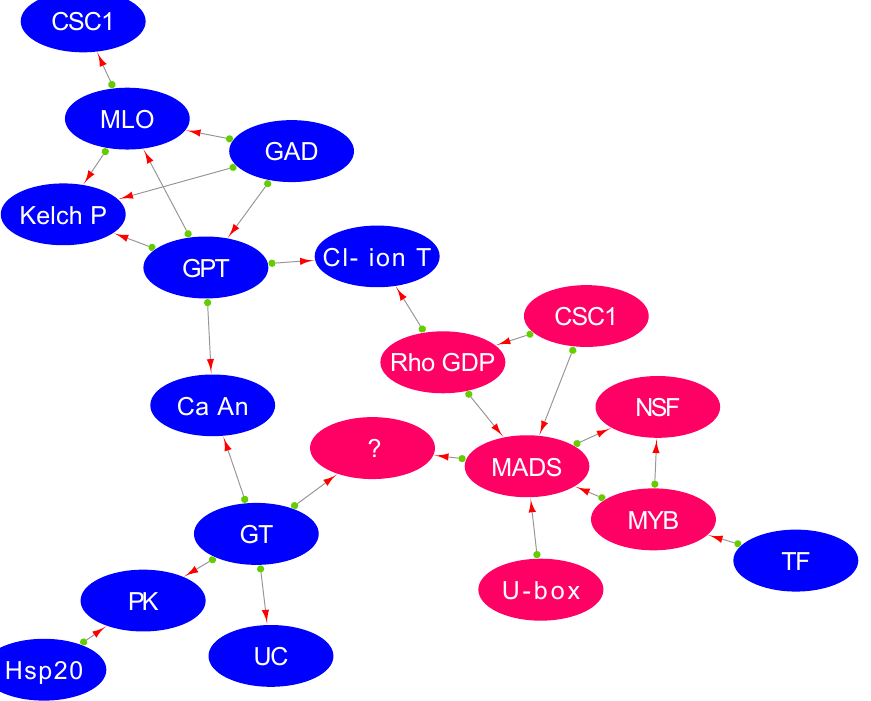
Figure 8. WGCNA gene regulatory network shows the ‘hub gene’ agamous MADS -box control the expression of genes involved in flower cell transport and development in response to salt stress.